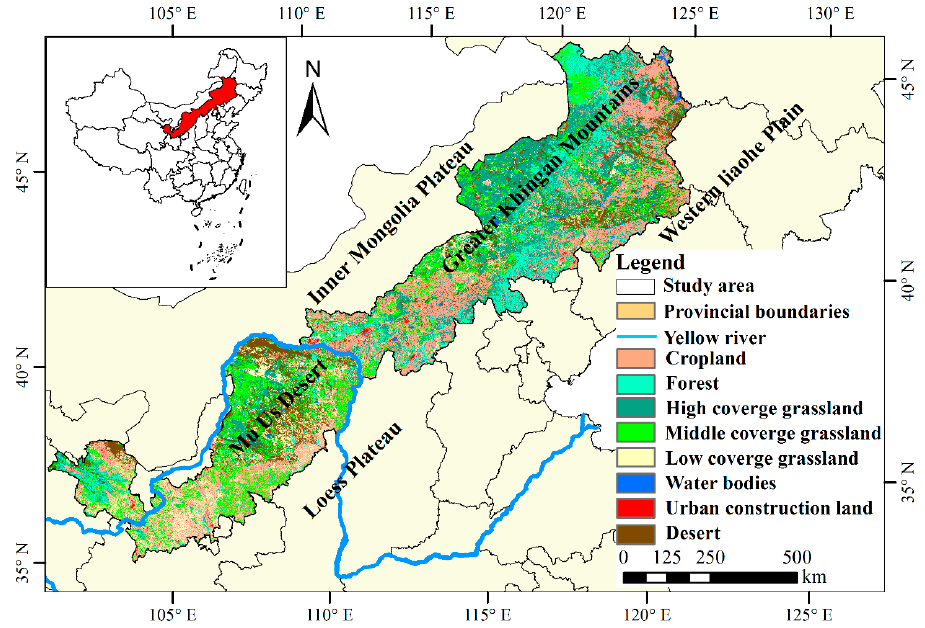
Figure 1. Location of the agropastoral ecotone in northern China (APENC) and land use and land cover types in